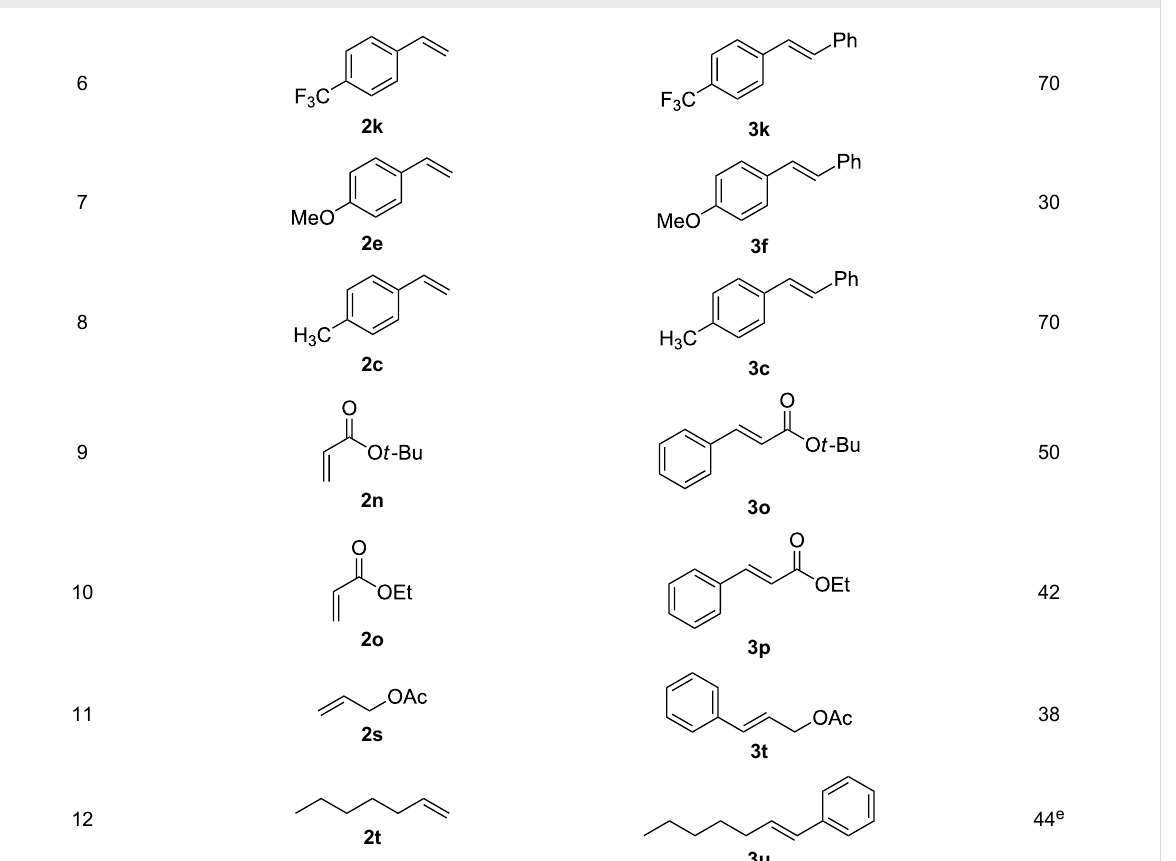
Table 4: Substrate scope in the Heck arylation reaction of phenylboronic acids with olefins. a (continued)